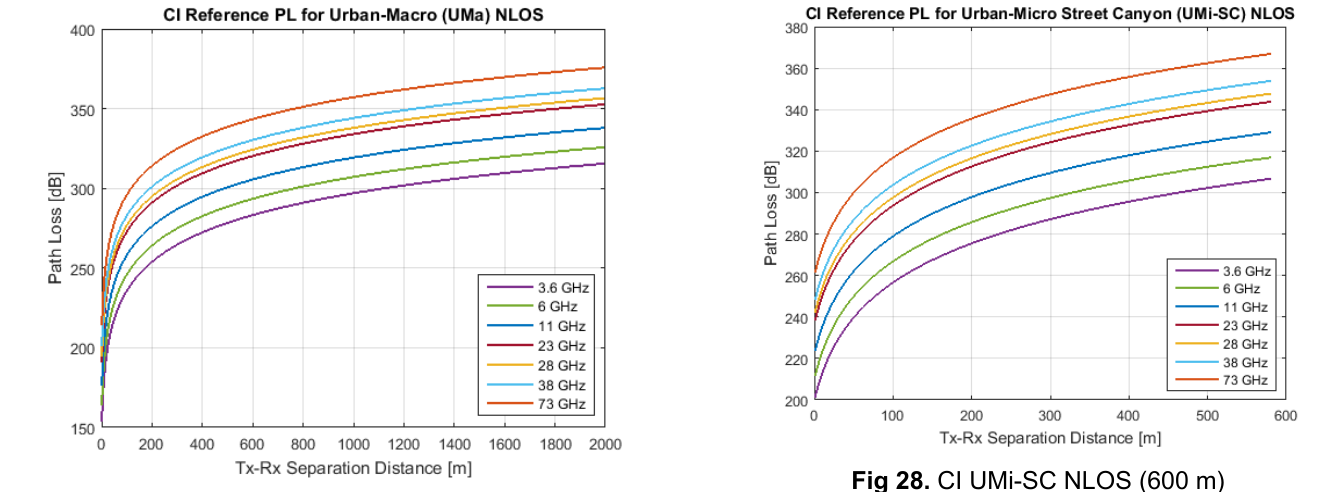
Fig 26. CI UMa NLOS (2000 m) The fig. 27 will show path loss for CI UMi street canyon LOS scenario for 250 meters distance.